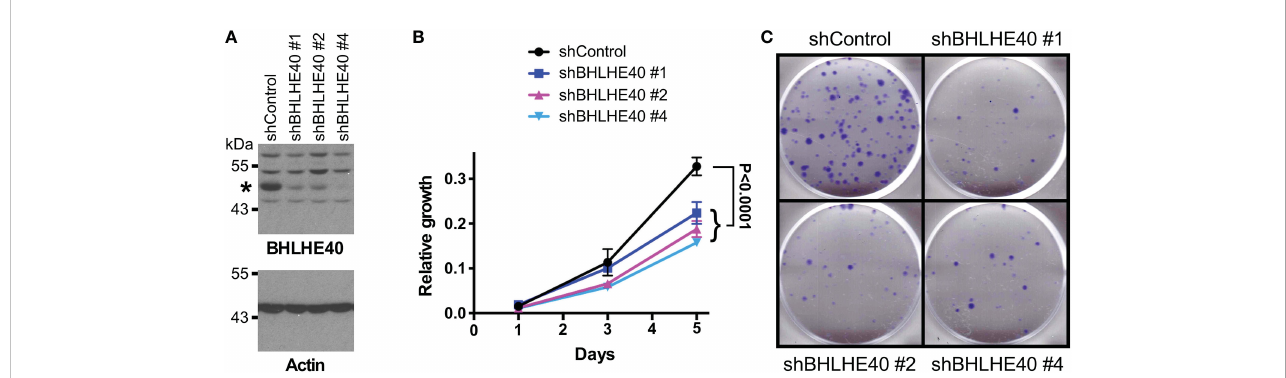
FIGURE 4 BHLHE40 promotes HCT116 growth. (A) Downregulation of BHLHE40 with three different shRNAs. Shown are BHLHE40 and actin Western blots. Asterisk marks BHLHE40. (B) Cell growth assay. Shown are means with standard deviations (n=3). Two-way ANOVA with post hoc Tukey ’ s multiple comparisons test. (C) Corresponding clonogenic assays with representative images.